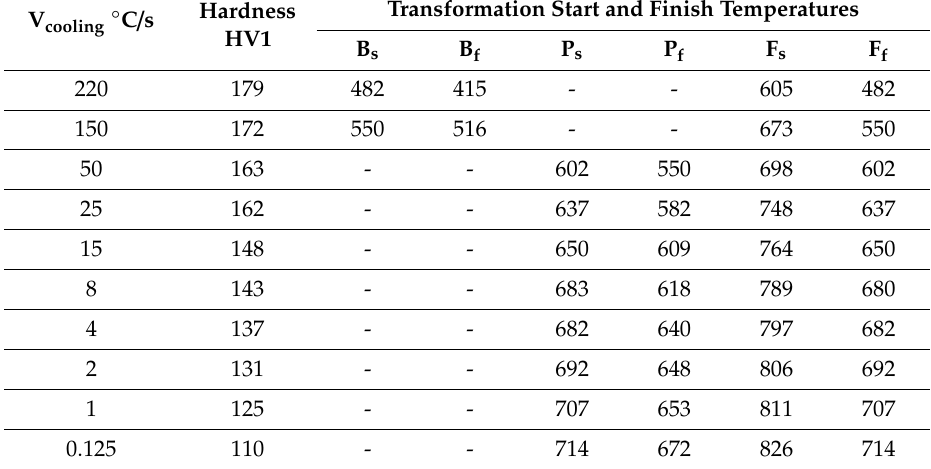
Table 4. Transformation start and finish temperatures are determined based on dilatometric analysis for undeformed